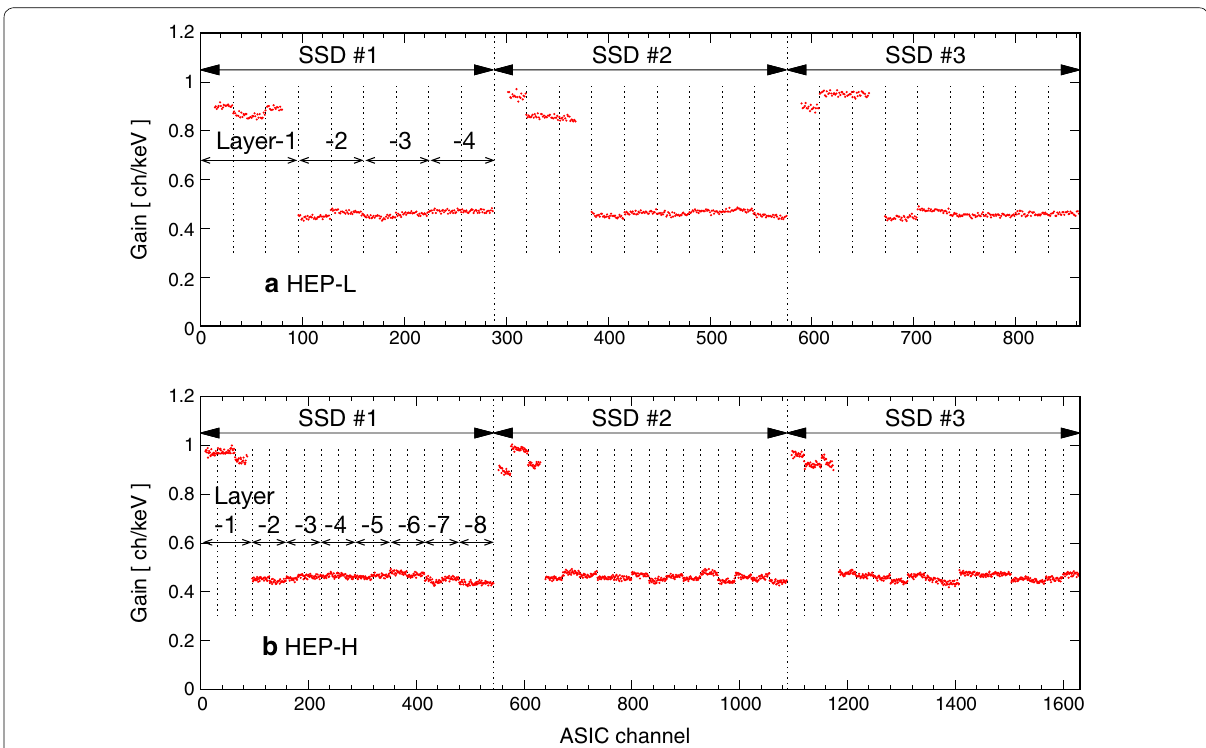
Fig. 9 VATA460.3 gain of all a HEP-L and b HEP-H channels of SSD modules. The dotted vertical lines indicate the first channel of each ASIC. The strips in the first layer are read out with three ASICs, and those in the lower layer are read out with two ASICs per layer. Therefore, 9 and 17 ASICs are used in the HEP-L and HEP-H SSD modules, respectively. Channels 0–95, 288–384, and 576–672 of HEP-L, and channels 0–95, 544–640, and 1088–1184 of HEP-H correspond to the first layer, which is the 50-μm-thick SSD